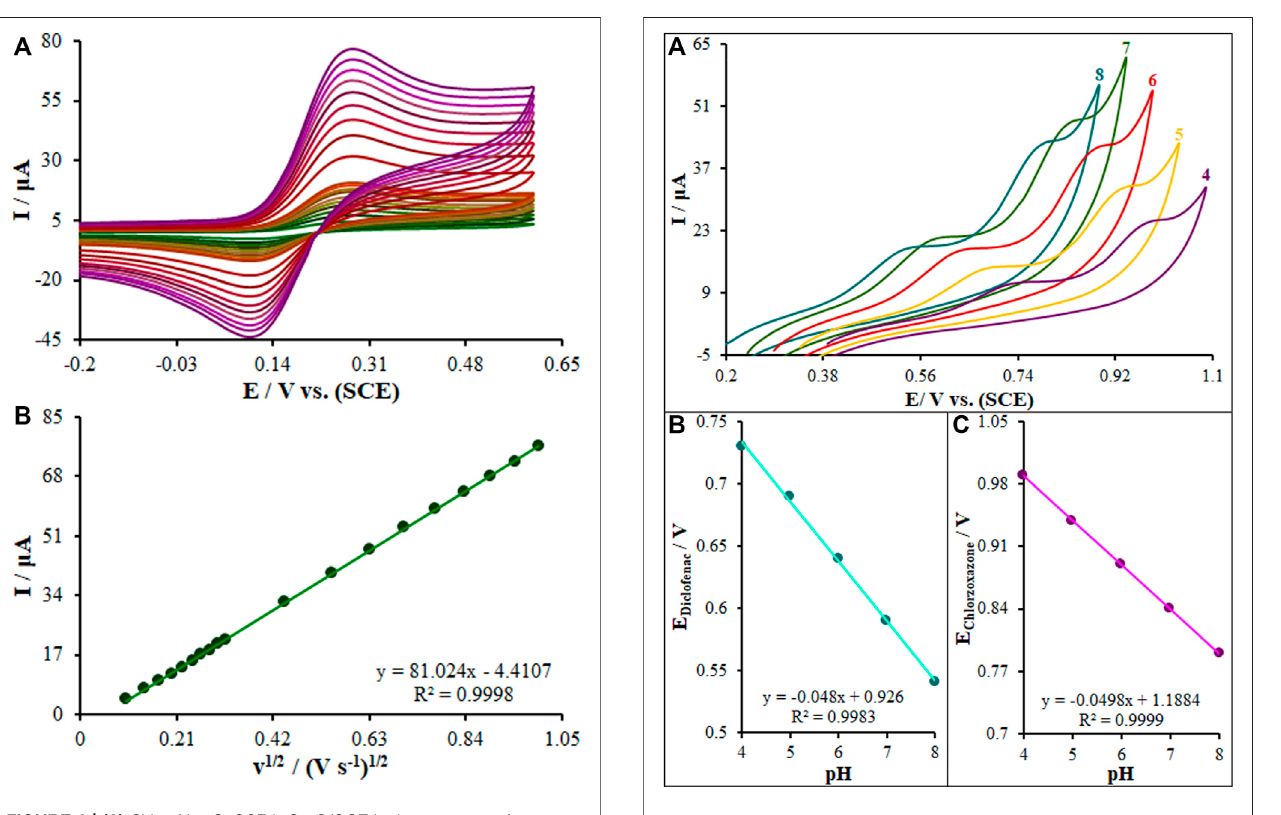
FIGURE 8 | Effect of pH on the peak current for the oxidation of diclofenac (275.0 µM) and chlorzoxazone (275.0 µM); pH = 4 – 8. In all cases, the scan rate was 50 mV s − 1 .